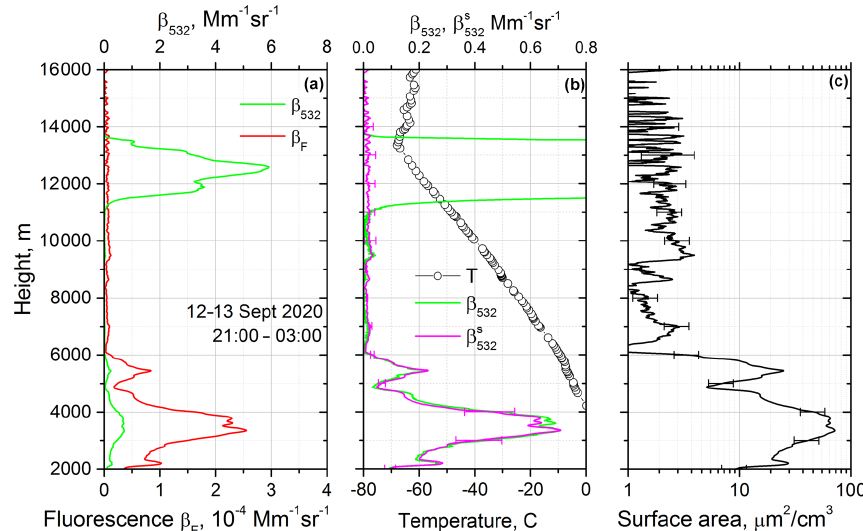
Figure 6. Observation of smoke fluorescence on 12–13 September 2020 at 21:00–03:00UTC. (a) Vertical profiles of the aerosol backscat- tering coefficient β 532 and fluorescence backscattering coefficient β F . (b) Aerosol backscattering coefficient β 532 , together with smoke backscattering coefficient β s , computed from β F for G F = 3.6 × 10 − 4 . (c) Surface area concentration of the smoke particles calculated 532 from β F using the respective conversion factor from Eq. (3). Open symbols show the temperature profile measured by the radiosonde at Herstmonceux.